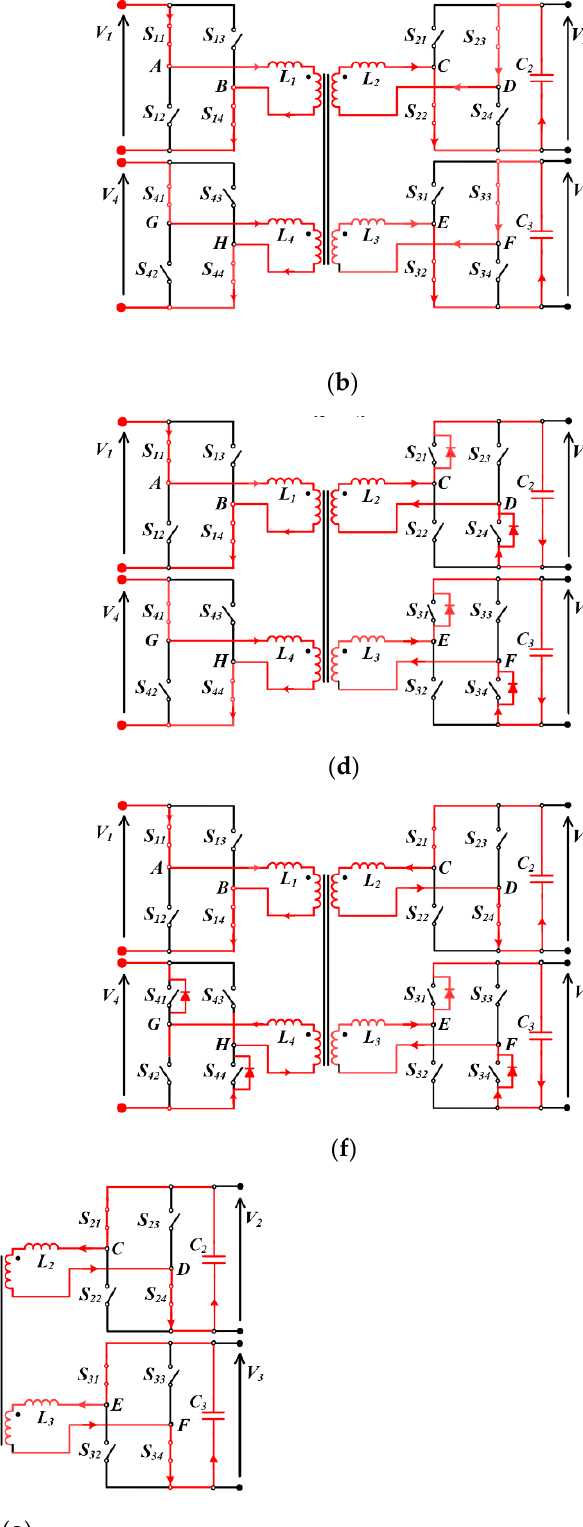
Table 2. Inductance currents into different time-intervals, with x ∈ {1, 2, 3, 4} . Time-Inteval, [0, π ]